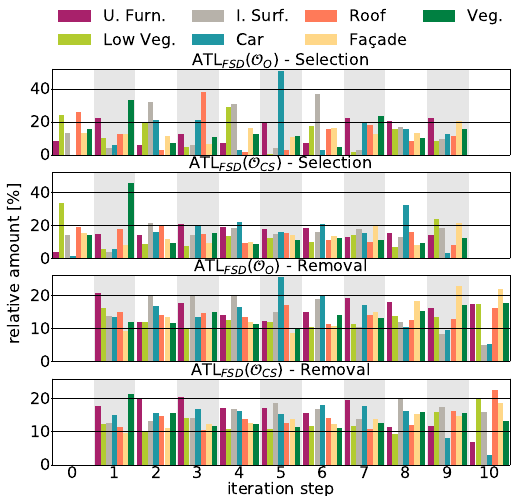
Figure 4. Sampled points of D T and deleted points of D S for scenario III (at iteration step 0 no points can be deleted since no samples of D T are present, hence the offset by 1 ).